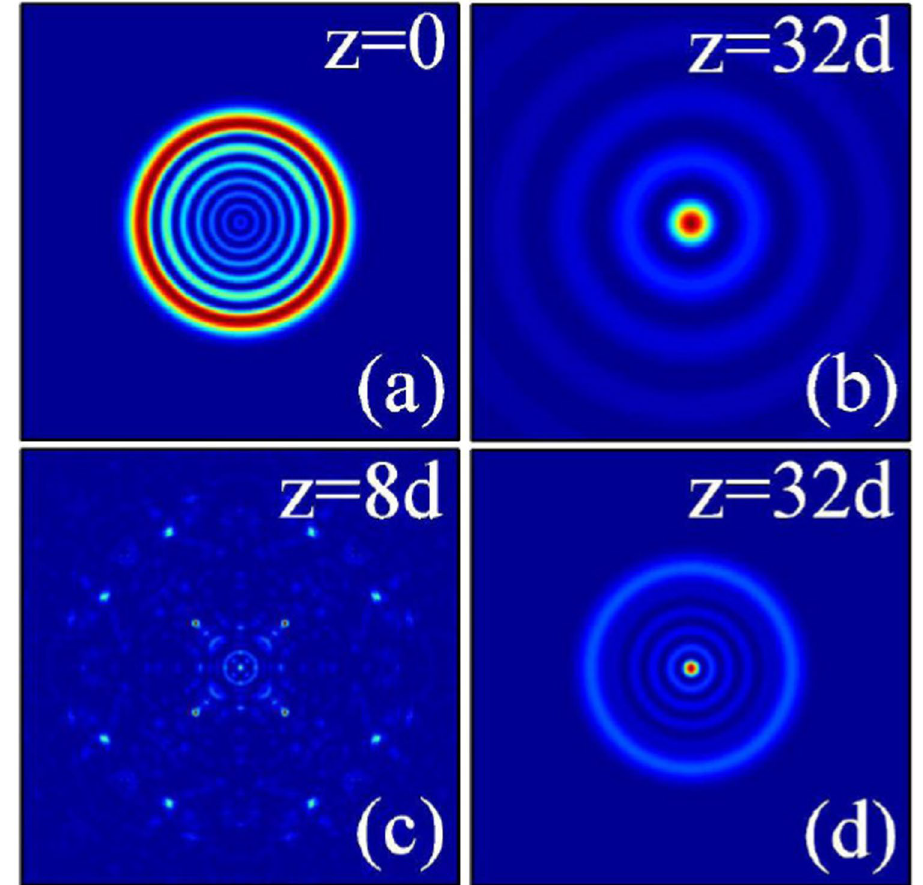
Figure 7. The intensity distributions of outward accelerating abruptly autofocusing Airy beam at different propagation distances in ( a – c ) local ( σ = 0), and ( d ) nonlocal nonlinear media, respectively. The initial parameters are m = 0, r 0 = 5, A = 1 ( a , b ), and A = 12 ( c , d ). The degree of nonlocality of Fig. 7(d) is σ =